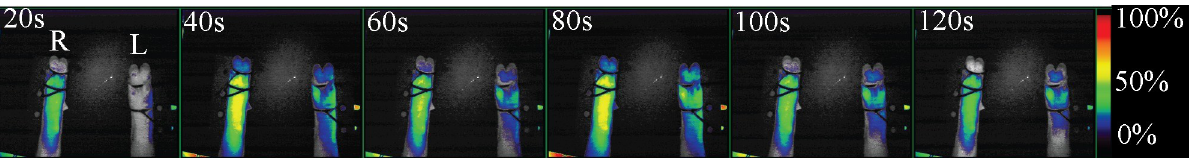
Fig 2. Pigs demonstrate plasma flow distal to the tourniquet. ICG signal is seen in both tourniqueted (left leg—L) and untourniqueted (right leg—R) distal limbs within 20 seconds of injection and increases over time. Ventral view. Fluorescent signal indicates ICG detection. Representative image shown, N = 4. Relative fluorescence by percent